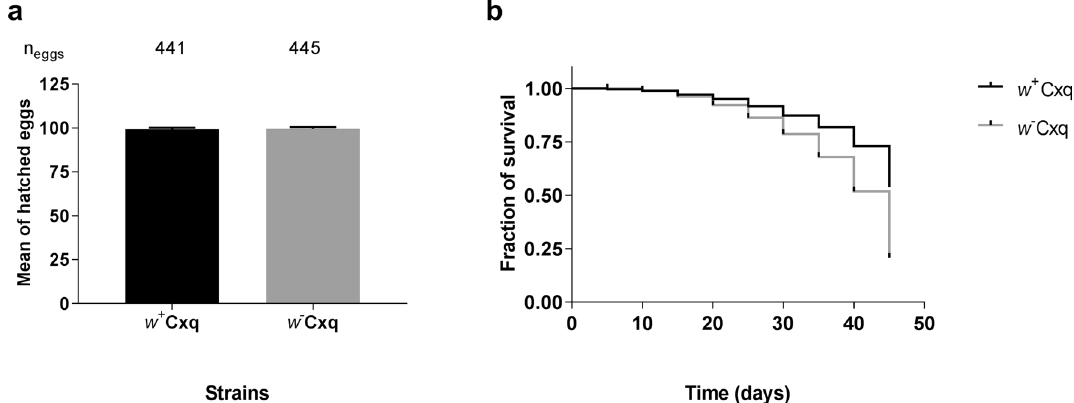
Figure 1. Wolbachia effect on fitness of Culex quinquefasciatus . ( a ) Mean of percentage of hatched eggs. N eggs : total eggs analyzed per line. ( b ) Kaplan–Meier survival curves of Wolbachia , ( w + )- or ( w −